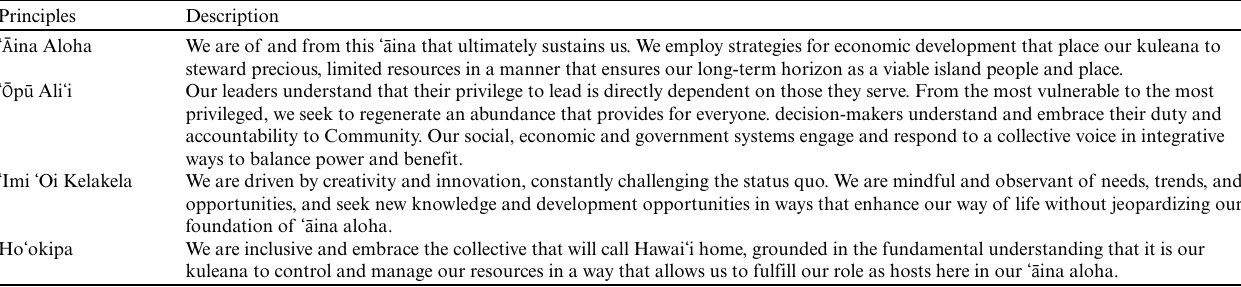
Table 2. ʻĀ ina Aloha economic futures guiding